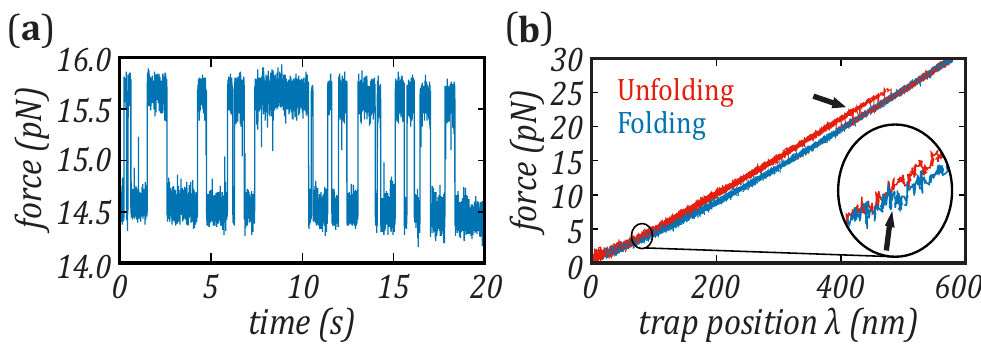
Figure 2. Single-molecule experiments on a DNA hairpin and protein barnase. ( a ) Equilibrium hopping experiments in the 20 bp DNA hairpin of Figure 1d: selected trace at the coexistence force ( ∼ 15 pN). ( b ) Non-equilibrium pulling experiments on barnase protein. The unfolding (red) and folding (blue) curves present hysteresis, with the folding events occurring at very low forces (below